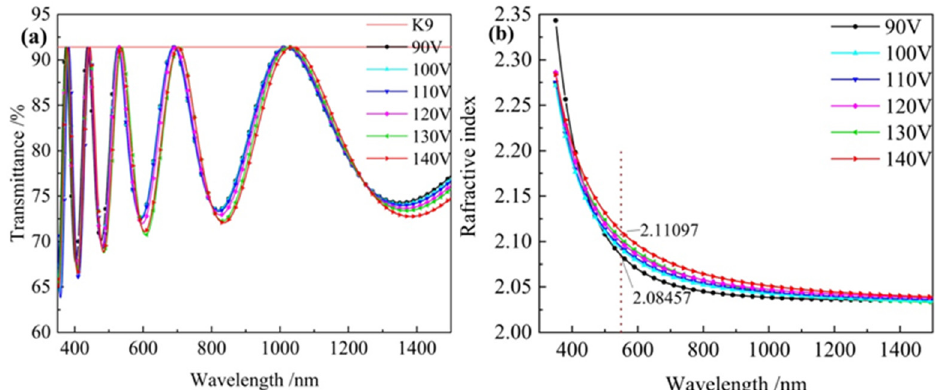
Figure 7. Transmittance and refractive index curve of single-layer Ta 2 O 5 film at different ion source bias. ( a ) Transmittance; ( b ) Refractive index.